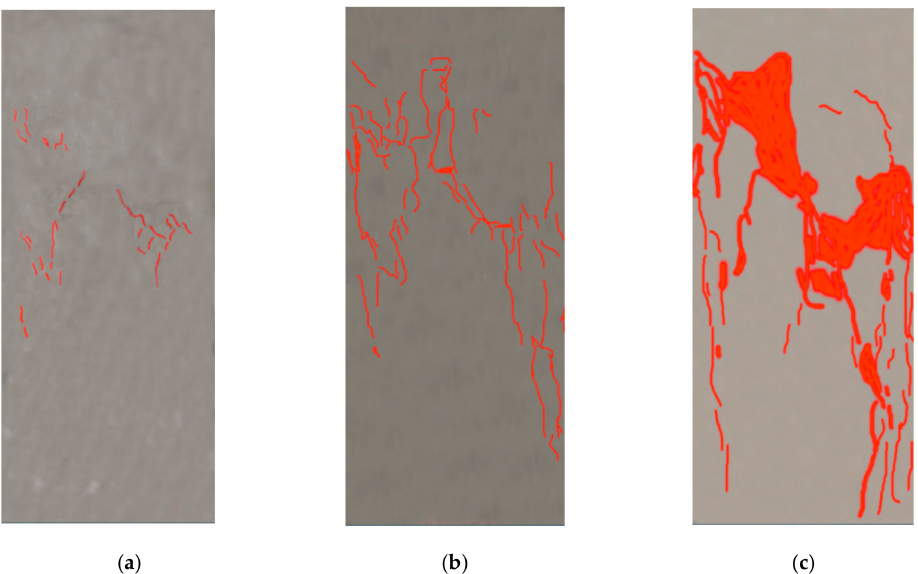
Figure 4. Crack development of specimen GC2-D1-33-Y. ( a ) Initial cracks. ( b ) At the peak load. ( c ) After the peak load.